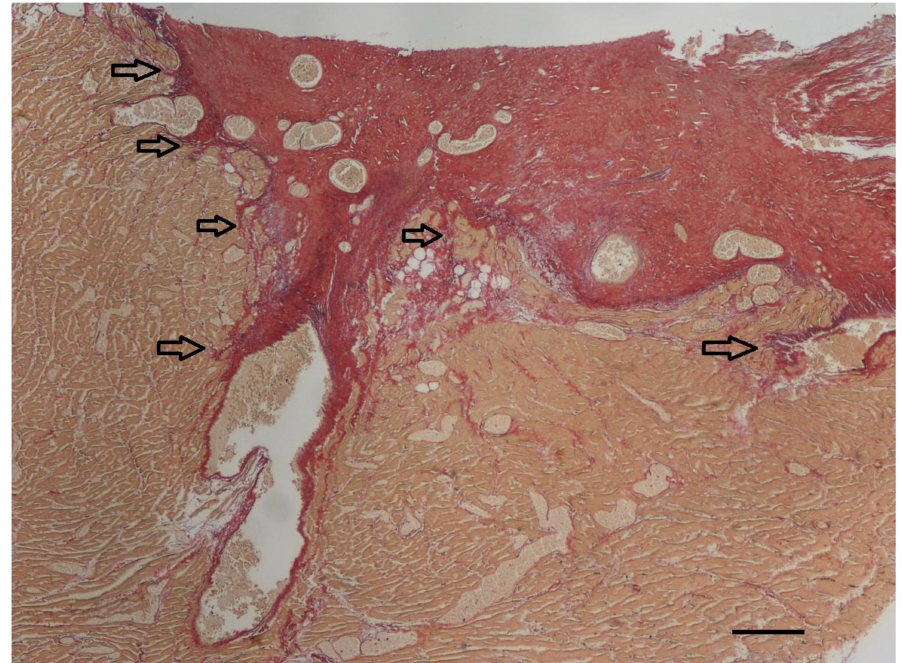
Figure 8. At the endocardial side of the longitudinal section of the right ventricular muscular hypertrophy (yellow), severe focal endocardial fibrosis (red) is present. The arrows indicate infiltration of collagen into the underlying myocardium. In addition to the thick subendocardial layer of collagen, collagen also surrounds the diffuse myocardial bundles throughout the underlying myocardium. Only a minimal increase in elastin fibers (violet) can be appreciated in this specimen accompanying the collagen fibers (red). Modified picrosirius red stain, bar = 200 µ